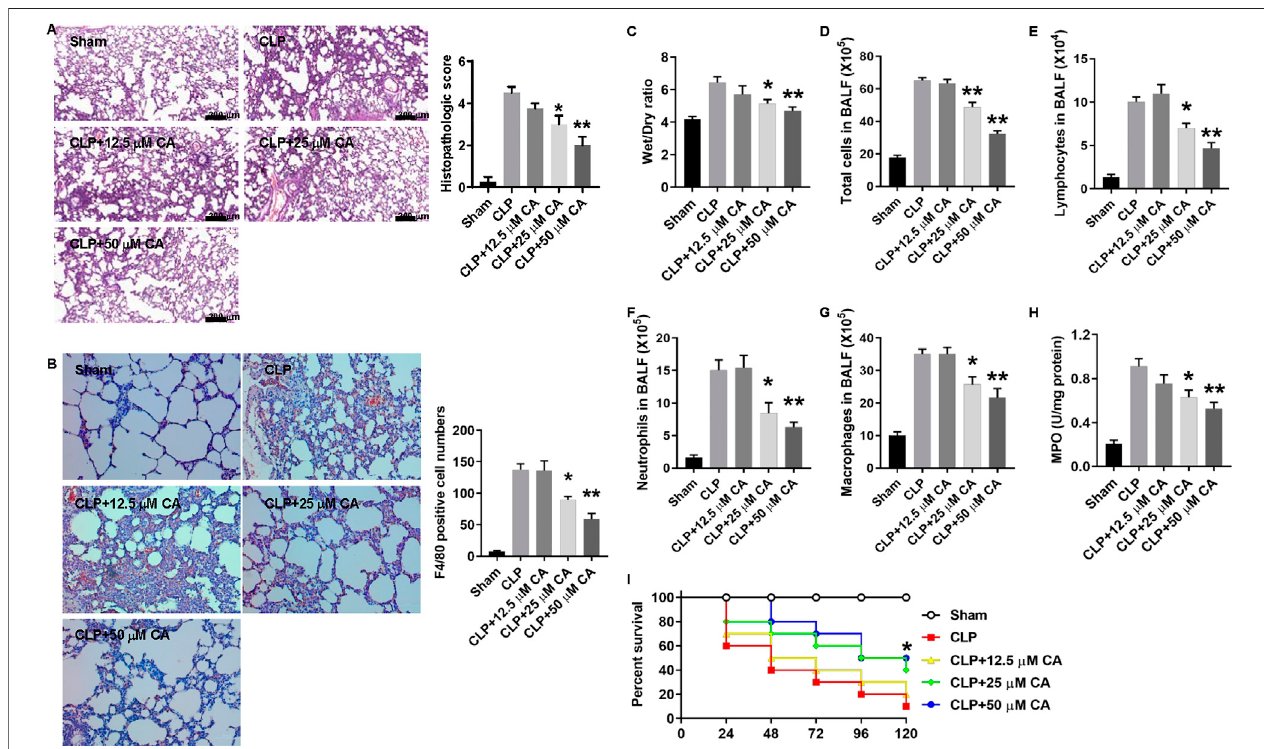
FIGURE 1 | Calycosin protects against cecal ligation and puncture (CLP)-induced septic acute lung injury. Mice were anesthetized and CLP procedure was performed. Sham mice were operated in the same procedure as CLP mice except for the ligation and puncture. The ligated mice were treated with calycosin by gavage at0and6 hafterCLP.AfterCLPfor12 h,micewereanesthetizedandsacri fi ced. (A) Lungtissueswerestainedwithhematoxylinandeosin.Histopathologicscoreswere calculated according to the severity of lung damage. (B) Lung tissue slides were stained by F4/80 immunohistochemistry. The numbers of positive cells were countedandstatisticallyanalyzed. (C) Thelowerpartoftherightlungwasexcisedandweighedtoobtainthewetweight.Then,thewetlungwasdriedinanovenat72 ° C for 48 h to obtain the dry weight. The ratio of wet to dry (W/D) weight was calculated to assess the lung edema. (D) The total cell number in the BALF was determined. (E – G) The cell numbers in the BALF, including macrophages, lymphocytes, and neutrophils, were determined by the Wright – Giemsa staining. (H) MPO activity was determined.Allthequantitativedata (A – G) arepresentedasmeans ± SEM.*p < 0.05;**p < 0.01vs.theCLPgroup. (I) Miceweretreatedwithdifferentdosesofcalycosin by gavage once per day after CLP. The mortality of mice was monitored every 24 h for 5 days after CLP (10 mice per group). The Kaplan – Meier method was used to compare the differences among groups. *p < 0.05 vs. the CLP group.